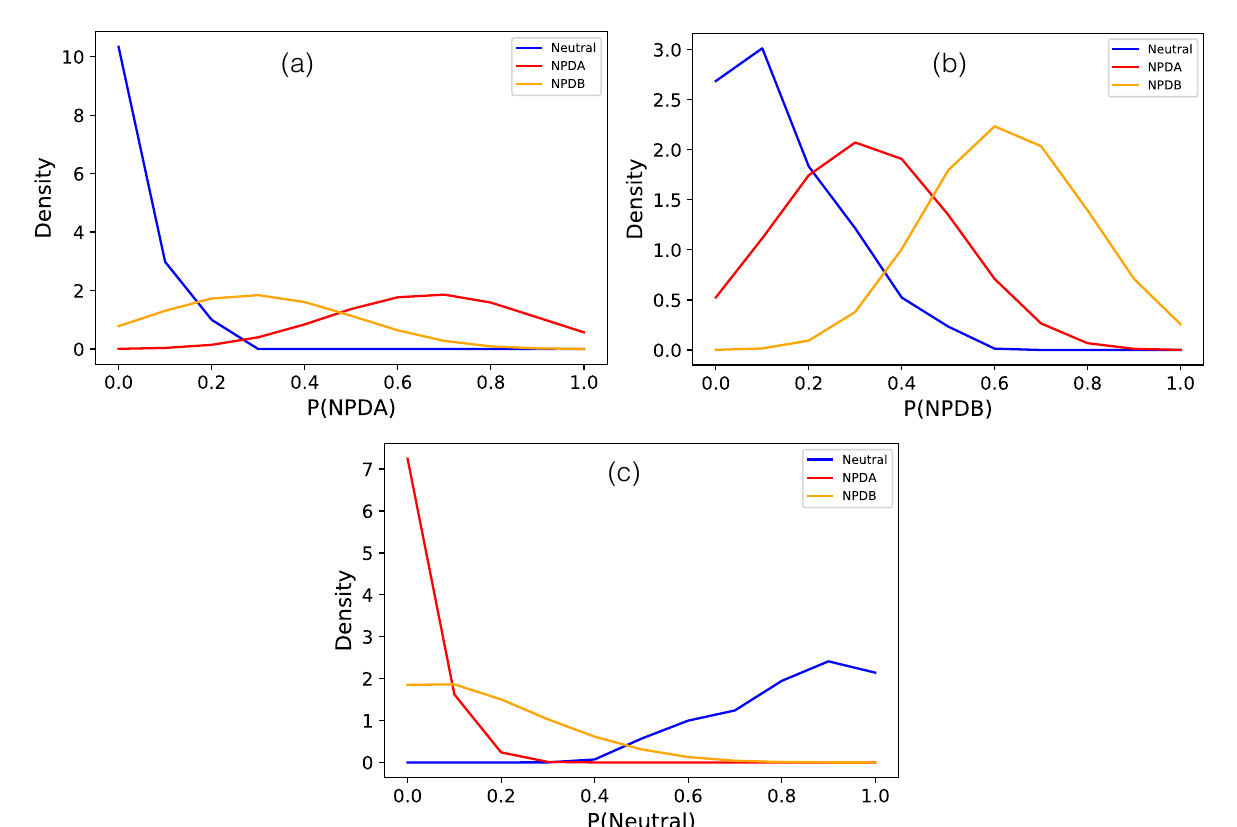
Figure 3. Probability density distributions of ( a ) P(NPDA), ( b ) P(NPDB) and ( c ) P(Neutral) as predicted by the SMPD1-ZooM predictor for neutral (in blue), NPDA-associated (in red) and NPDB-associated variants (in